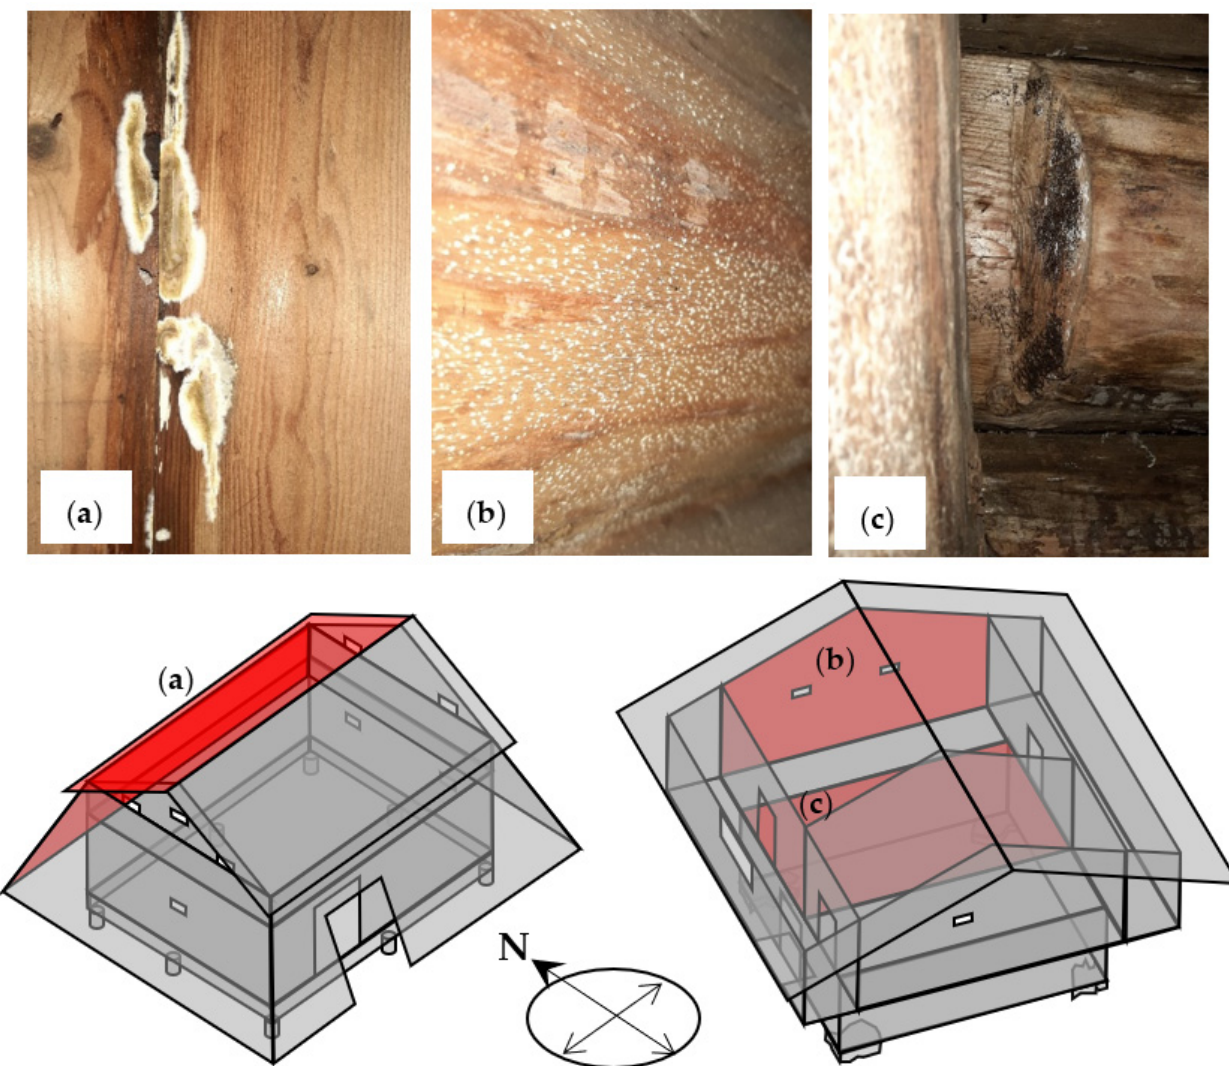
Figure 7. ( a ) Brown-rot fungi ( Coniophora puteana ) detected at the positions highlighted with red color at the Fadum storehouse. ( b ) Scopulariopsis colonies and ( c ) Myxomycetes detected at the positions highlighted with red color at the Heierstad loft.